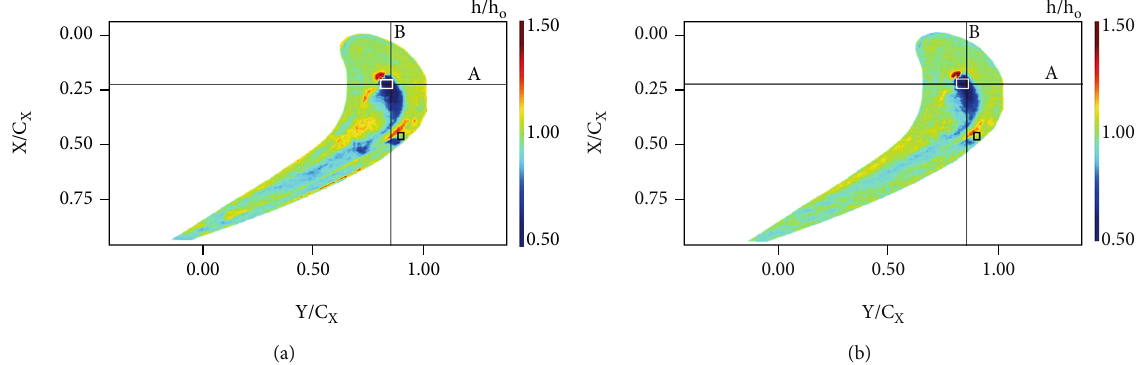
Figure 8: Locations A and B as well as regions for area averaging presented with respect to heat transfer coe ffi cient ratio distribution, with fi lm cooling. (a) Dataset 10, 0.8mm tip gap, BR = 1 : 51 . (b) Dataset 4, 1.4mm tip gap, BR = 1 : 58